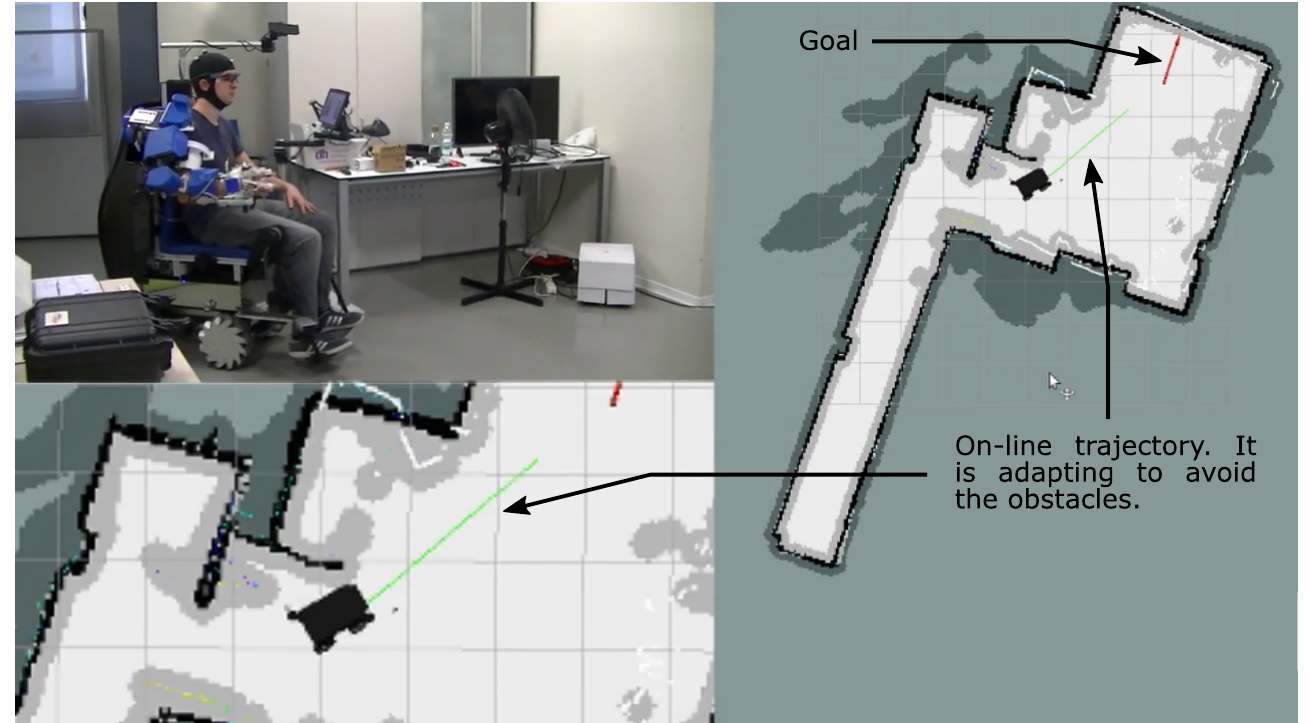
Figure 2. Pictures of the monitoring of the navigation algorithm with obstacle avoidance in a real